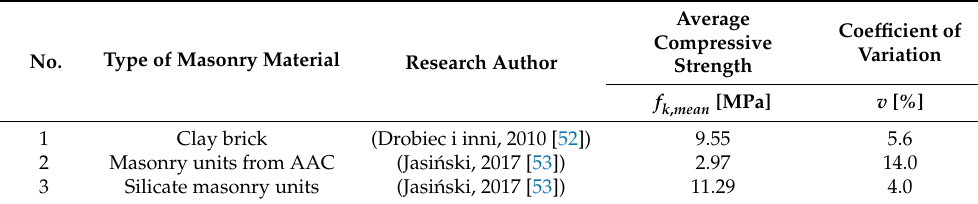
Table 9. Sample results of experimental tests of masonry structures presented in national literature— average masonry strength, the coefficient of variation.